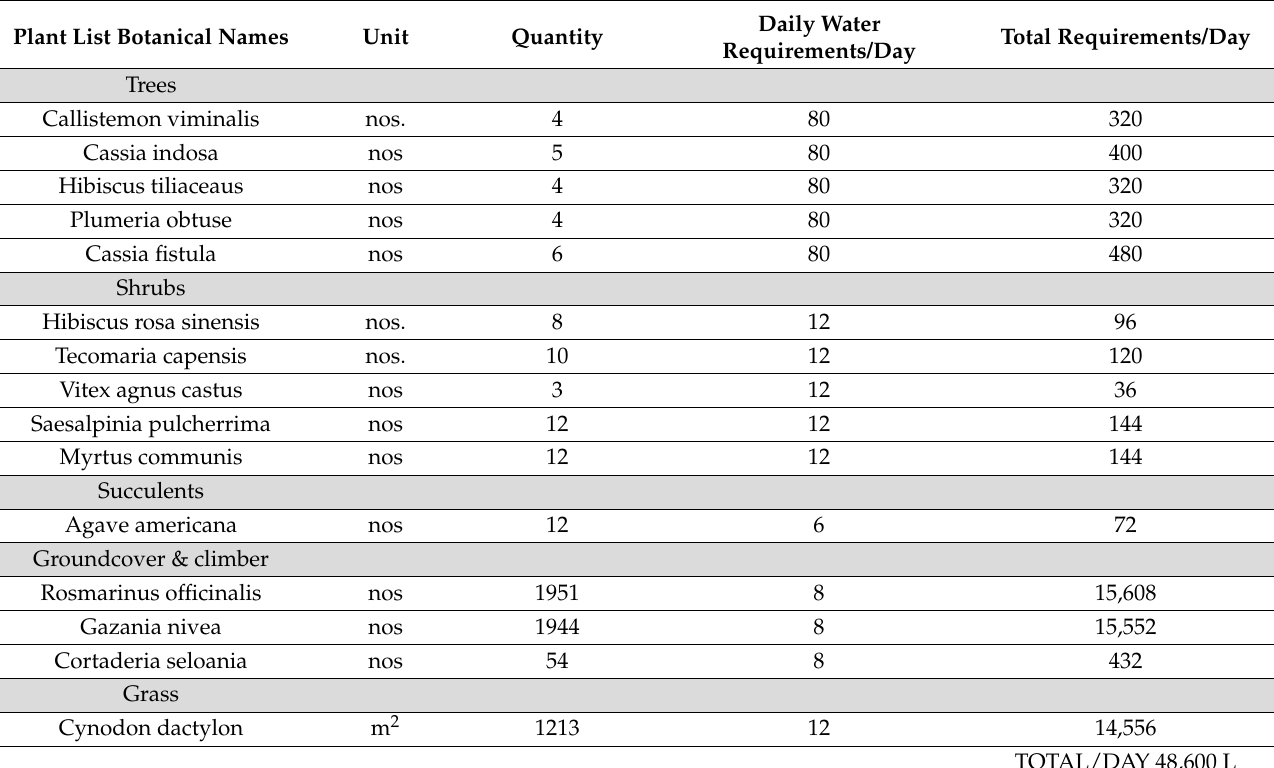
Table A2. Water consumption for each softscape item: previous situation for PARKING 4 land- scape